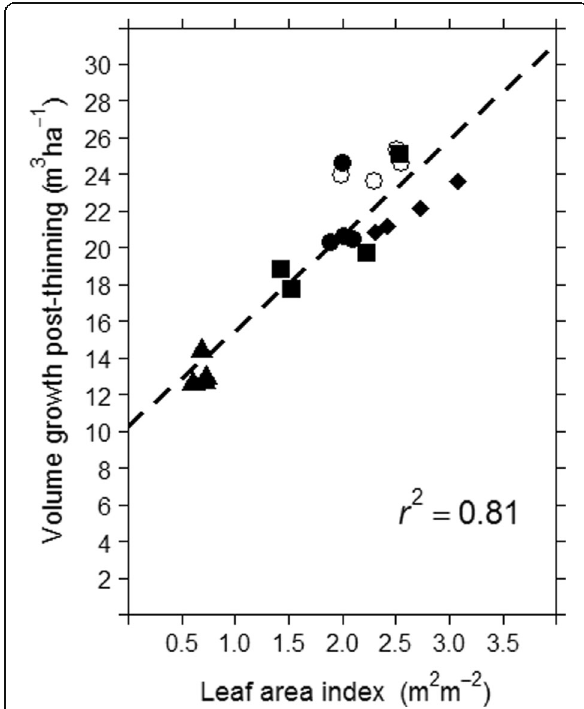
Fig. 4 Relationship between leaf area index and incremental volume growth 1 year post thinning for sites P800 (filled triangles), P1100 (filled squares), P1500 (open circles), P1700 (filled circles), and P1750 (filled